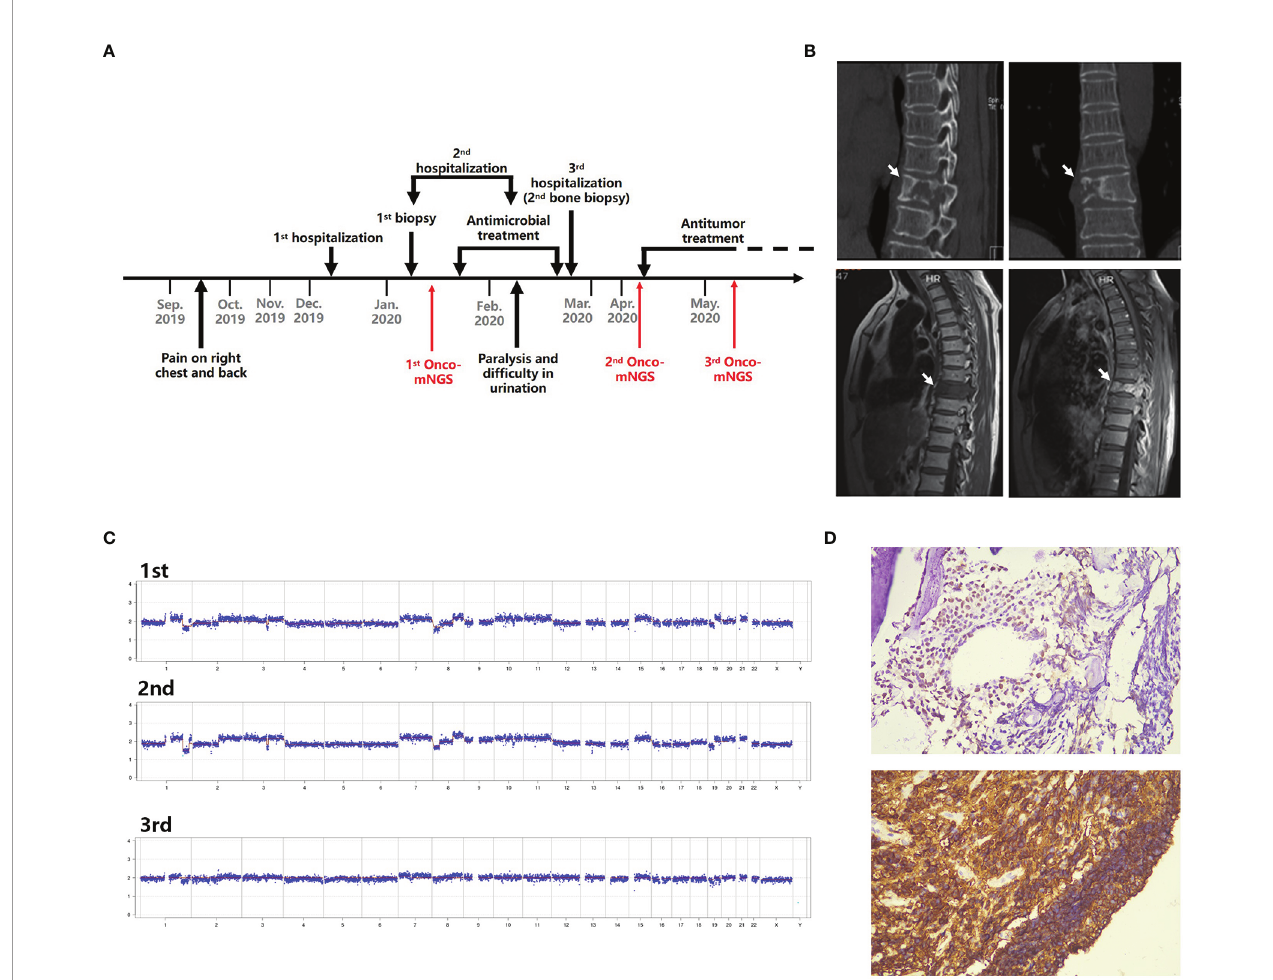
FIGURE 4 | Schematic diagram of Onco-mNGS and a clinical case in which Onco-mNGS was applied and cancer was diagnosed. (A) Timeline beginning with the patient ’ s initial complaint and ending with a fi nal diagnosis. Major events during the course of the patient ’ s illness are indicated by arrows. (B) CT and MRI scans obtained during the patient ’ s fi rst hospitalization revealed bone destruction of the 9 th thoracic vertebrae and right appendix with a paravertebral soft tissue shadow. The lesion is indicated by the white arrow. (C) Three CNV results generated at different sampling times. The fi rst and second NGS tests were performed before chemotherapy, and the third one was performed after chemotherapy. (D) Results of the repeated bone biopsy showing in fi ltrating, actively proliferating B lymphocytes evidenced by 60% CD20 and Ki67 positive, consistent with manifestation of diffuse large B cell